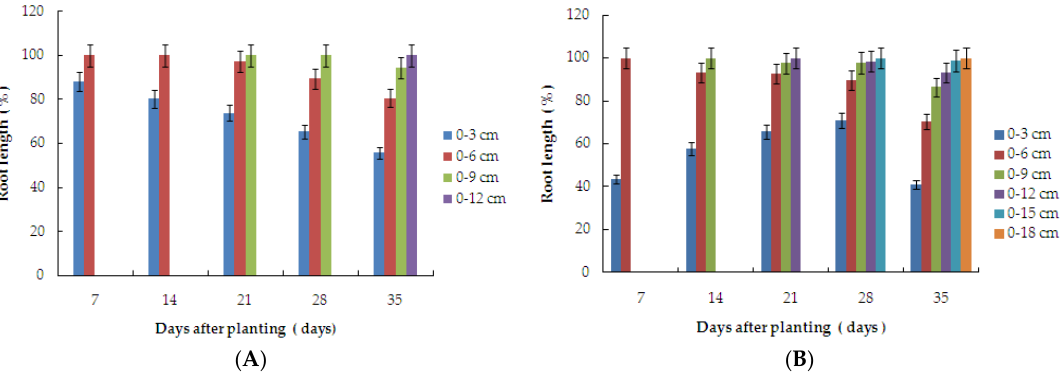
Figure 3. Percentage of root distribution at different times after lettuce planting. ( A ) Horizontal distanced from plant, cm; ( B ) Substrate depth, cm.